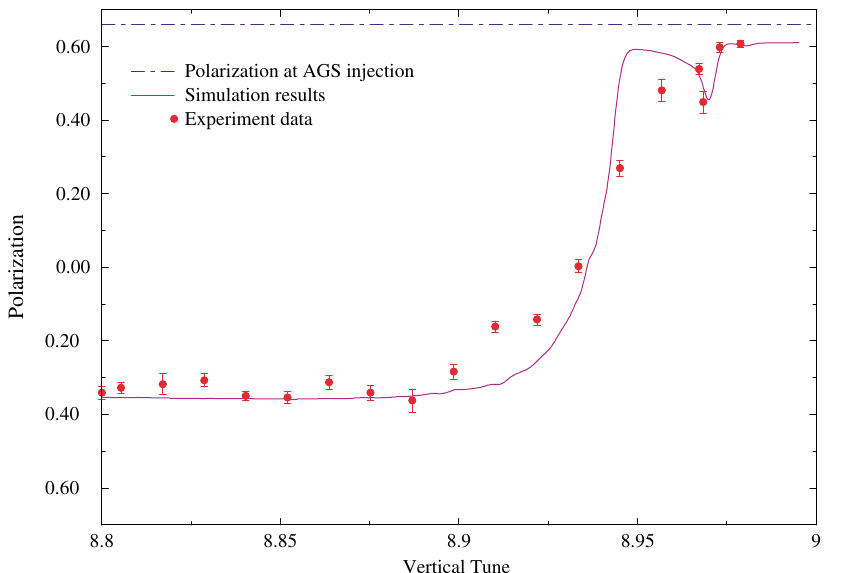
FIG. 3. (Color) The measured vertical polarization as a function of the vertical betatron tune for an 11.4% partial Siberian snake. The dashed straight line indicates the polarization level measured at the end of the linac. Since the two imperfection resonances in the Booster have been corrected by harmonic orbit correctors, this is also the beam polarization at AGS injection. The solid curve shows the results of combined multiparticle simulations and DEPOL